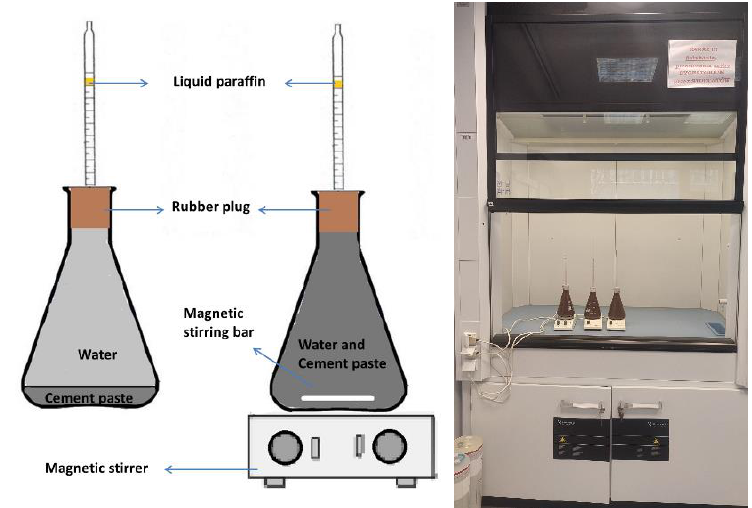
Figure 1. Chemical shrinkage measurement set-up.